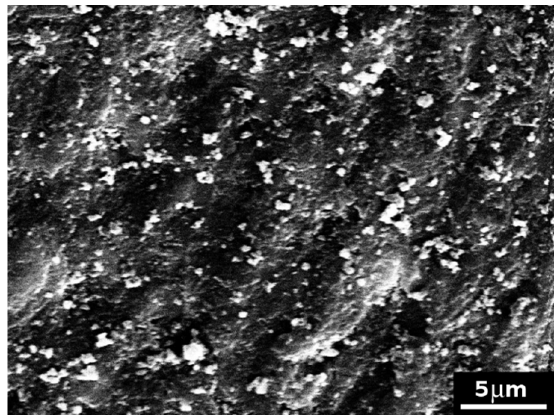
Figure 5. SEM picture (×3500) of a model dentine disc (control sample) treated with formulation 1, highlighting the presence of large and small clasts formed at the surface.